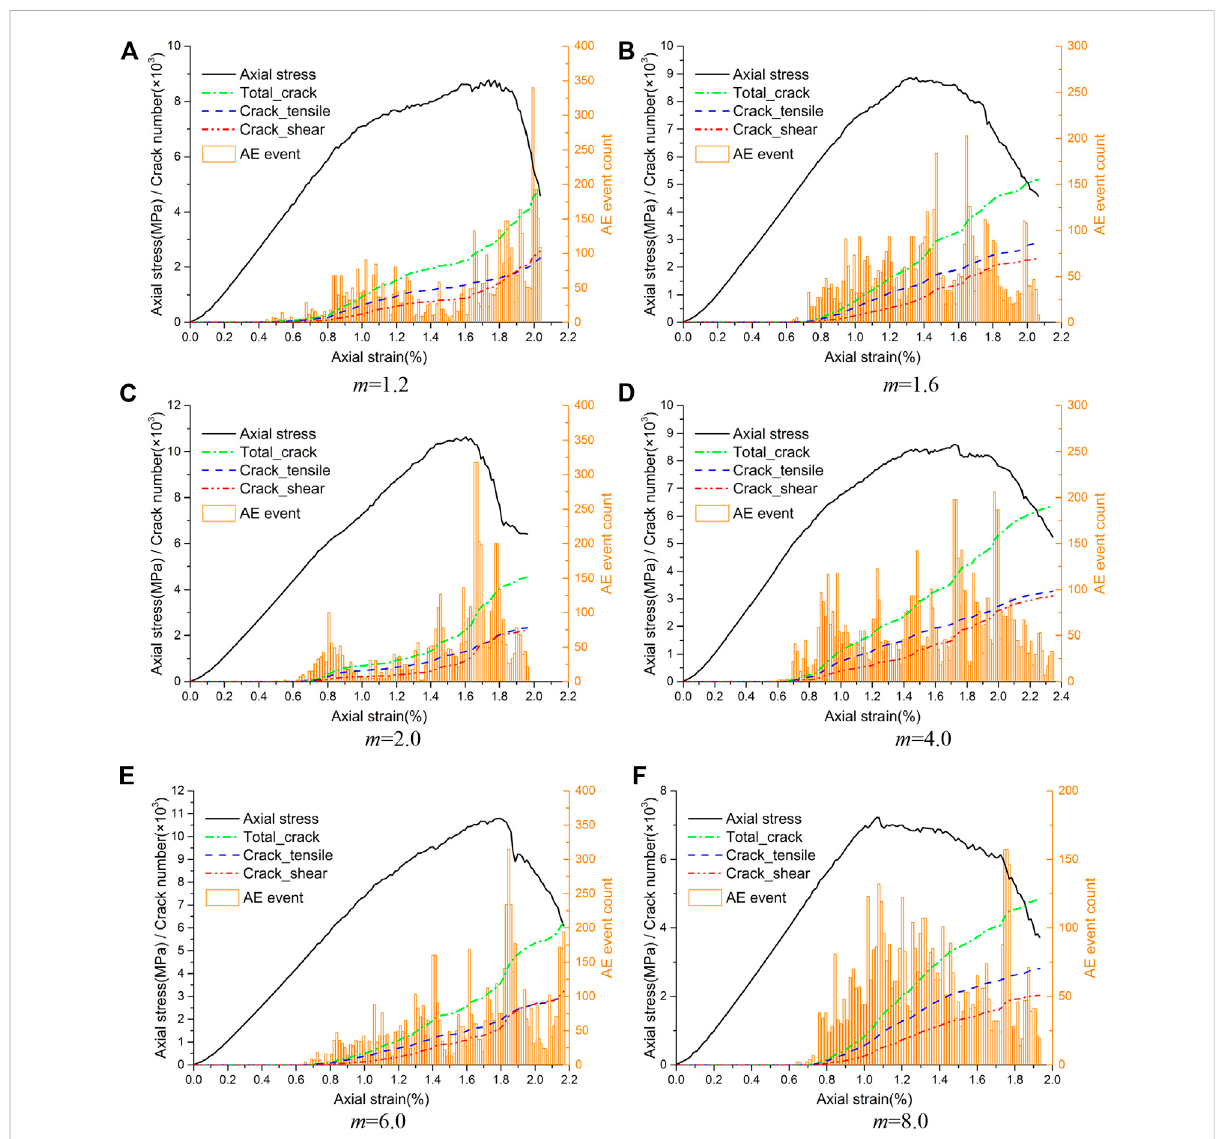
AE event intensities at peak stress decrease with increasing porosity. Figure 14 illustrates the crack distribution of the models having different porosities of random circular defects at 60% of the peak stress after failure. The red and blue lines in Figure 14 represent the shear and tensile cracks that occurred in the model under uniaxial compression, respectively. The Arabic numerals that follow the color legends are the numbers of the corresponding cracks. The number of total cracks, shear cracks, and tensile cracks in the failed specimens all decrease with increasing defect porosity. Furthermore, Figure 14